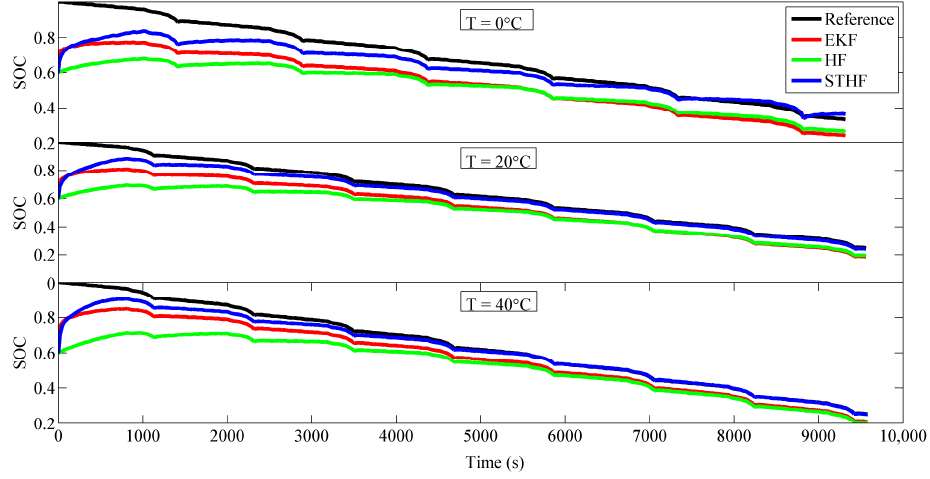
Figure 15. Estimation results of STHF, HF, and EKF with an initial error.